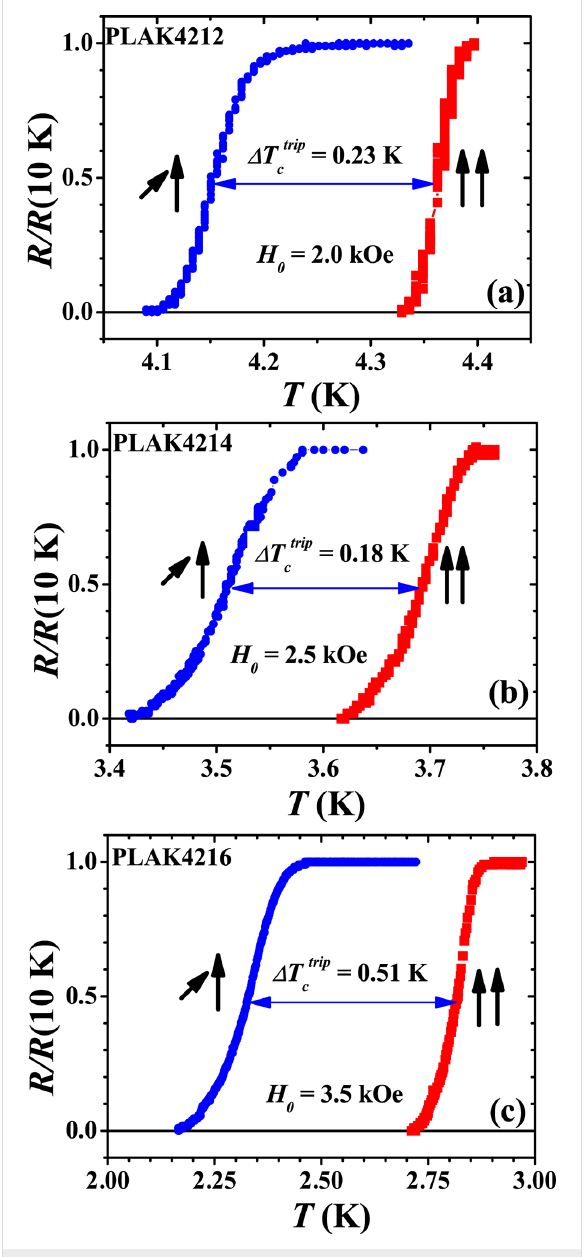
Figure 2: SC transition curves for the P and PP configuration of the cooling field used to fix the direction of the magnetization of the Ni layer and the applied magnetic field H 0 , which rotates the magnetiza- tion of the HA layer: (a) sample PLAK4212 at H 0 = 2 kOe; (b) sample PLAK4214 at H 0 = 2.5 kOe; (c) sample PLAK4216 at H 0 = 3.5